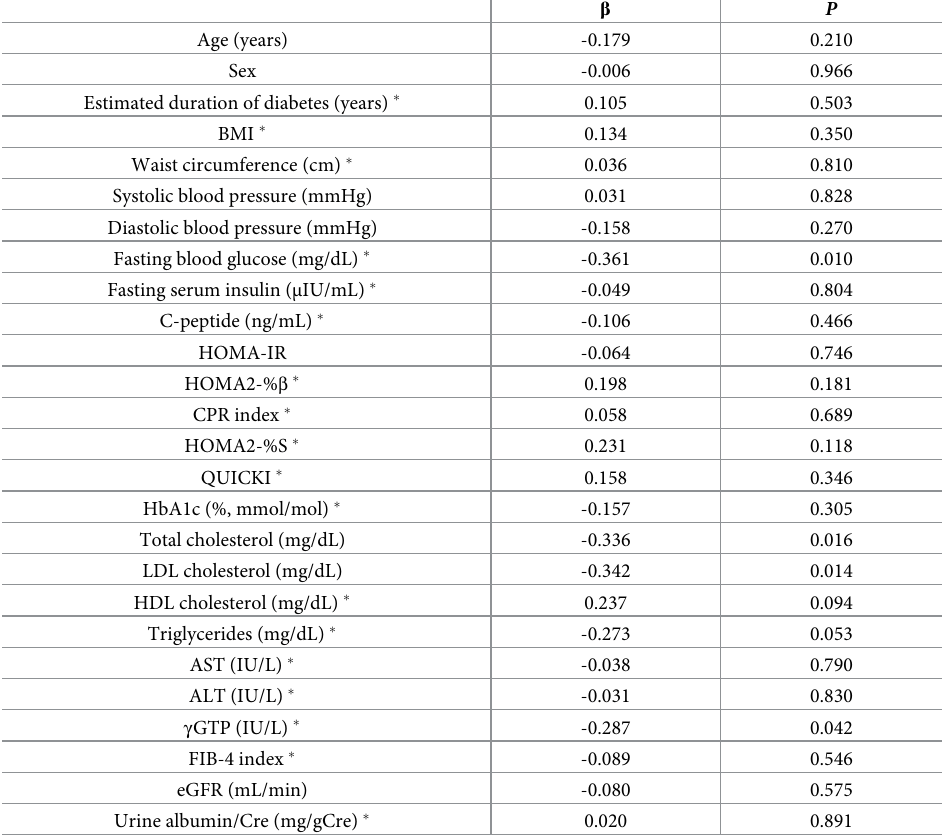
Table 2. Univariate linear regression analyses for serum SerpinB1 levels in T2DM